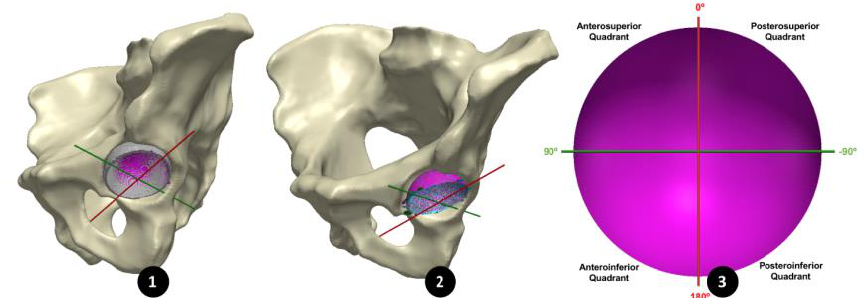
Figure 2. (1) An acetabular surface (purple) registered to the 3D model of its acetabular cup (grey), segmented form its 3D CT images. (2) All 20 acetabular surfaces registered using the CAPP axis, maintaining their in vivo orientation. (3) The CAPP axis (red) used to divide the acetabular surface into four quadrants.